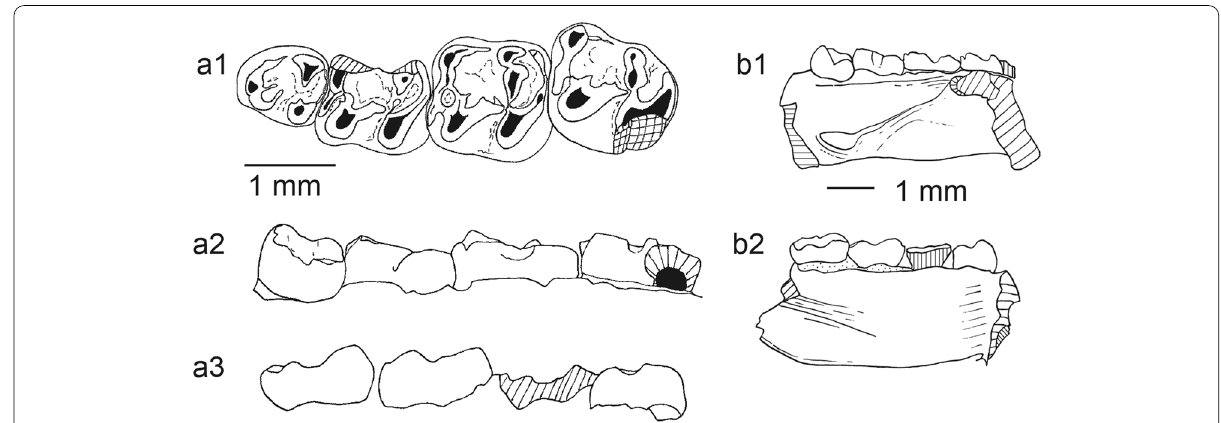
Fig. 54 Eoelfomys nov. gen. nov. sp. from Egerkingen (Swiss Jura). Ek H003, a left p4 to m3; a1, occlusal view; a2, buccal aspect; a3, lingual aspect. b left incomplete dentary; b1, buccal side; b2, lingual side. Scale bar